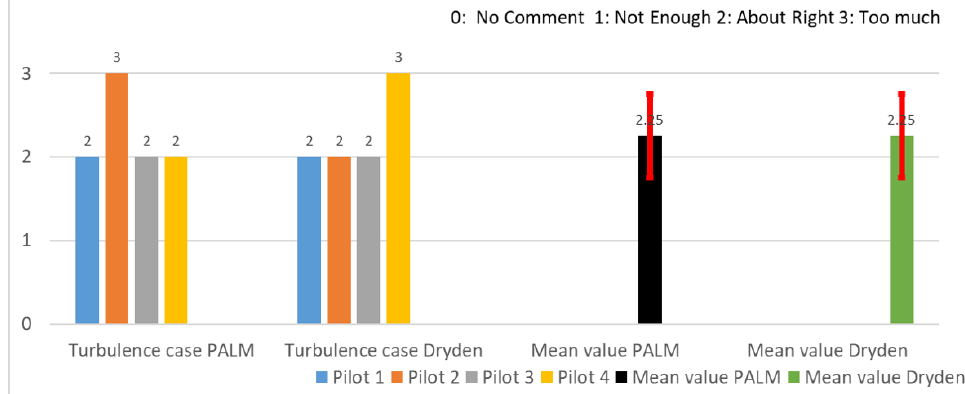
Figure A6. Correctness of relative amplitudes of disturbances